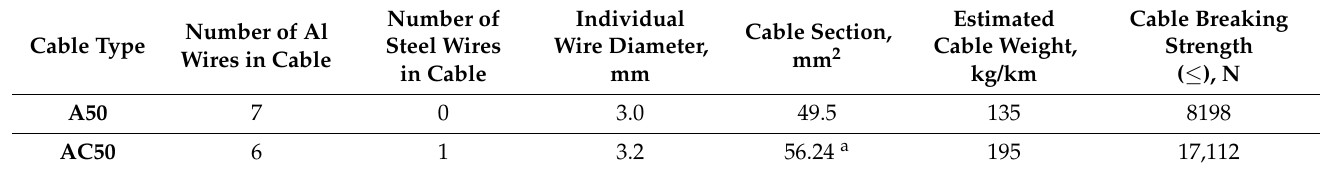
Table 1. Characteristics of A50 and AC50 overhead power-line cables according to Ref.